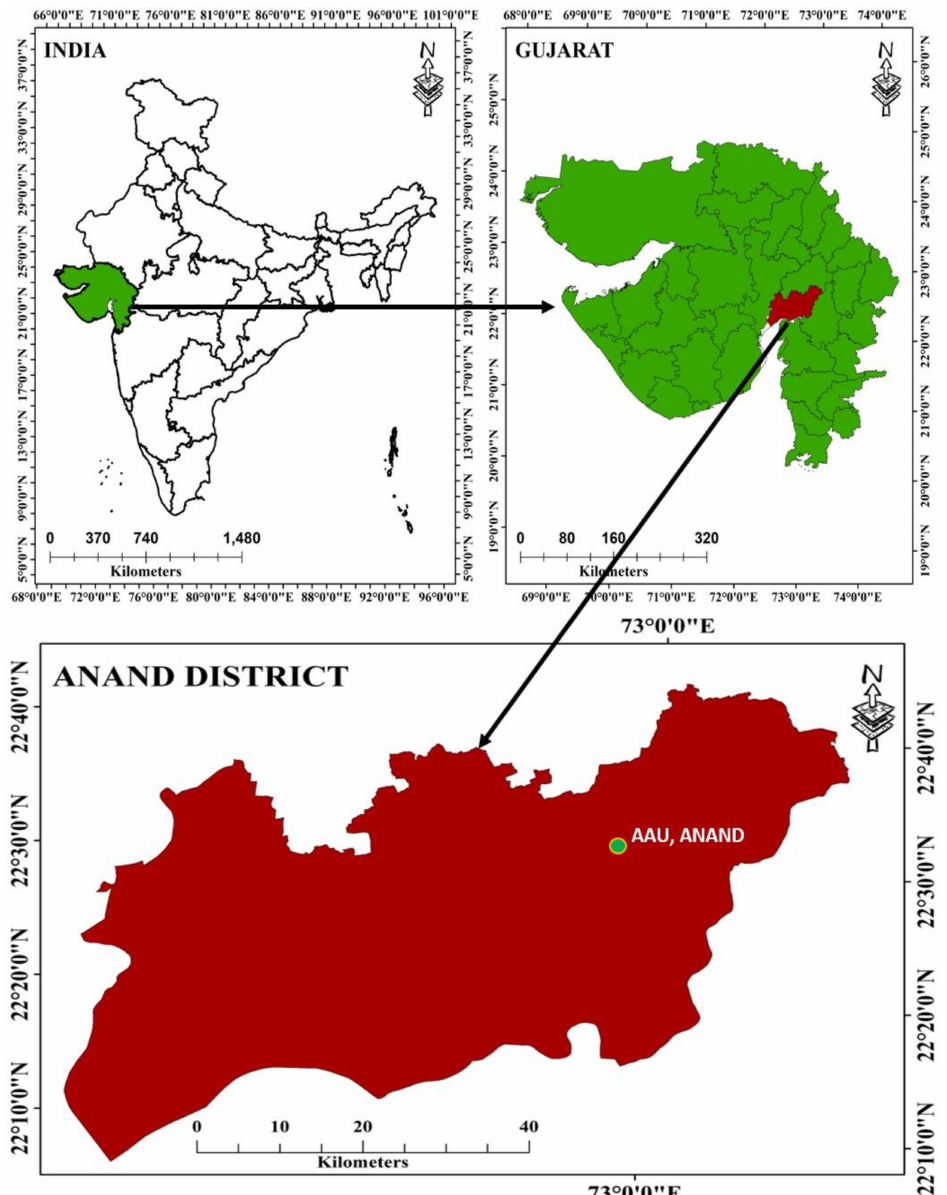
Figure 1. Location of the experimental